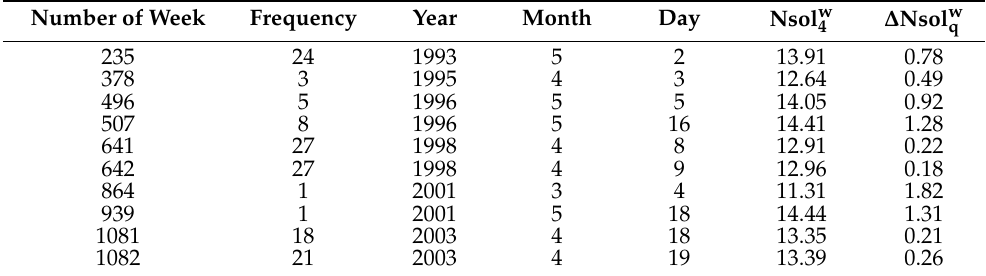
Table 4. Candidate weeks in the Colmenarejo Este location in the spring